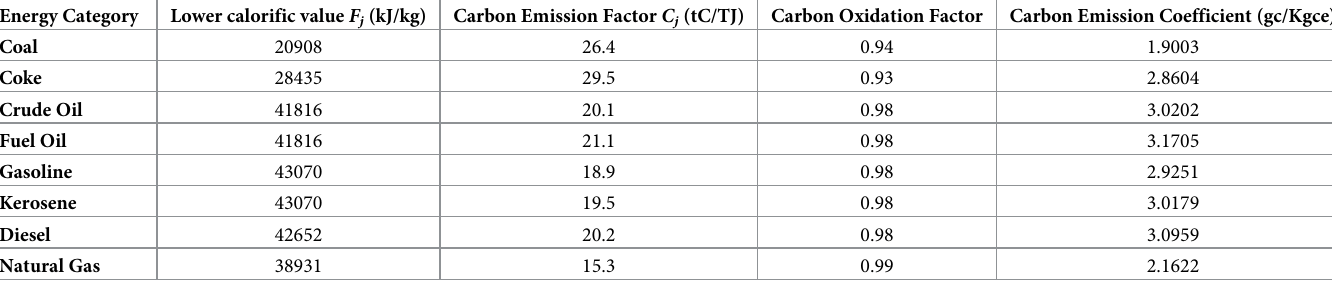
Table 1. Carbon emission coefficients of various